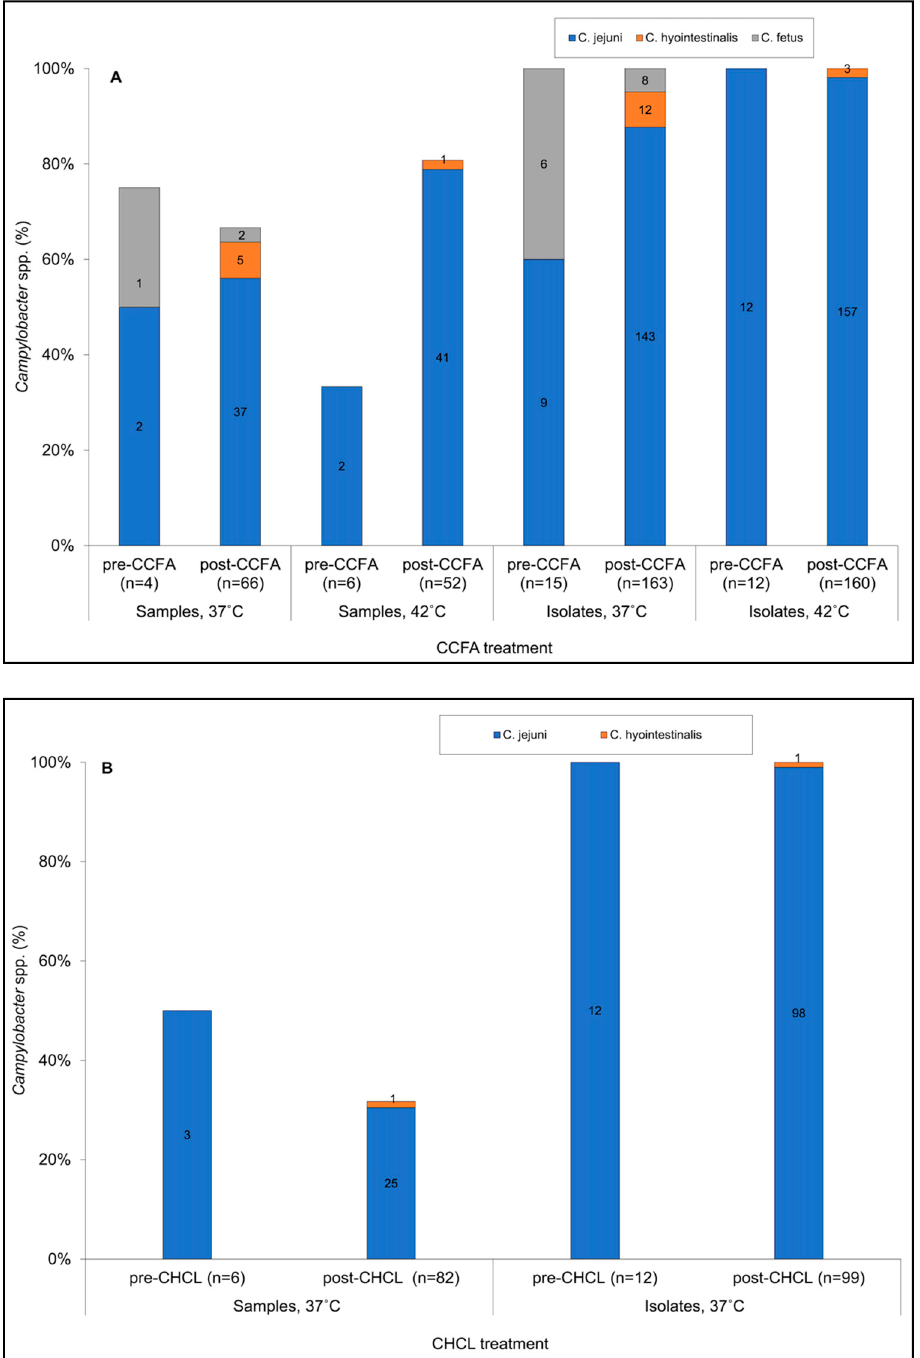
Figure 1. Prevalence of the different Campylobacter species in fecal samples from ( A ) ceftiofur crystalline-free acid (CCFA) and ( B ) ceftiofur hydrochloride (CHCL) groups. Campylobacter species designations are as in the inset, with blue for C. jejuni , orange for C. hyointestinalis , and gray for C. fetus . Pre-CCFA or pre-CHCL correspond to data pre-treatment (time 0), while post-CCFA and post-CHCL correspond to the compilation of all data post-treatment. “Samples” refers to fecal samples collected at different time points from the steers, while “Isolates” refers to Campylobacter cultures that were recovered from the fecal samples following enrichment and single colony purification. The four panels shown for the CCFA group in ( A ) correspond to, from left to right, ( 1 ), data from all fecal samples following incubation at 37 °C; ( 2 ), data from all fecal samples following incubation at 42 °C; ( 3 ), data from all Campylobacter isolates obtained following incubation at 37 °C; and ( 4 ), data from all Campylobacter isolates obtained following incubation at 42 °C. The two groups shown for the CHCL group in ( B ) correspond to data from all fecal samples ( left ) and data from all Campylobacter isolates ( right ). CHCL samples were only incubated at 37 °C. Campylobacter detection and species determinations were as described in Materials and Methods.